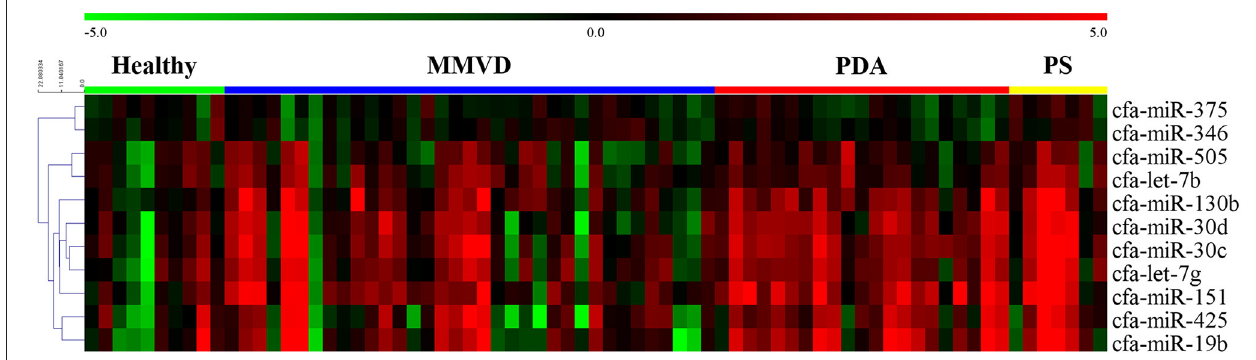
FIGURE 2 | Heat map of overall miRNA expression according to disease type. Sample species shown at the top and the miRNA species shown on the right. Unsupervised average link hierarchical clustering of miRNAs with similar expressions using the Euclidean distance measure. Red indicates relatively high expression of miRNA, and green indicates low expression of miRNA. MMVD, myxomatous mitral valve degeneration; PDA, patent ductus arteriosus; PS, pulmonic stenosis.